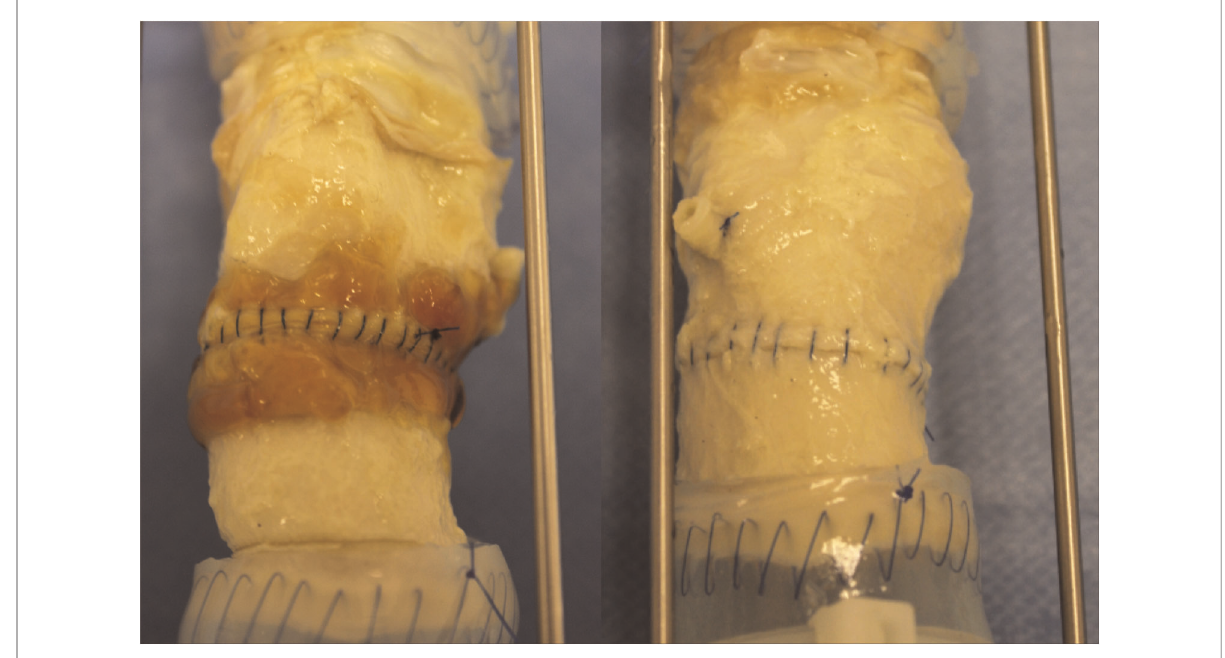
FIGURE 2 Images of the anastomotic suture lines of the test (left) and control (right) groups at 120 million